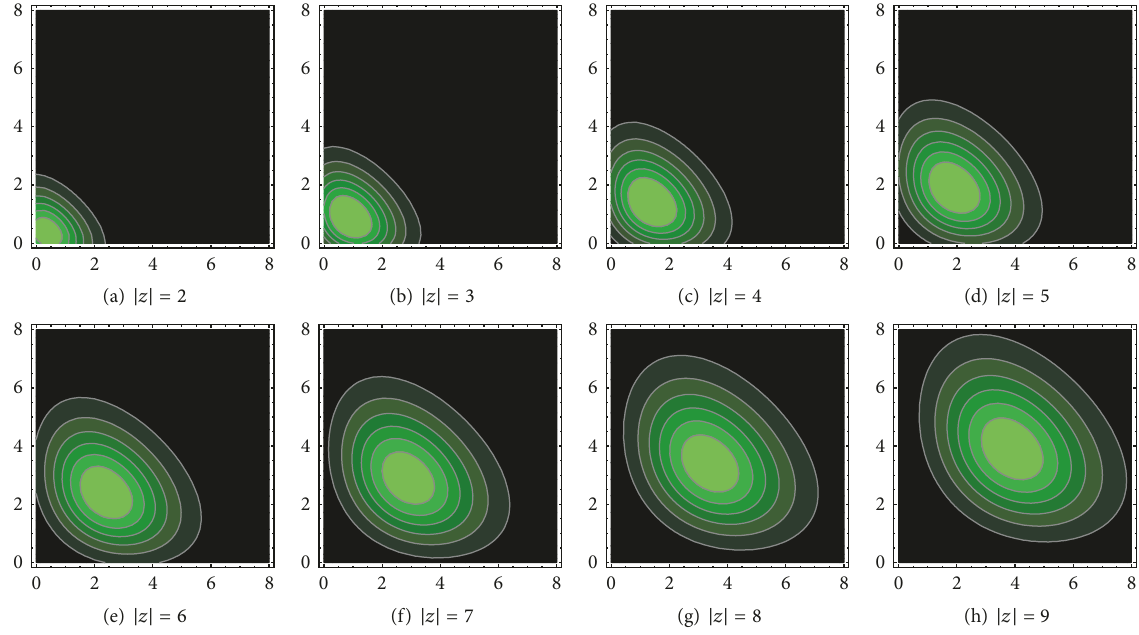
Figure 6: The distribution P 퐸 (𝑛,𝑚, |𝑧|) in the 𝑛𝑚 -plane for the indicated values of |𝑧| . Compare with Figure